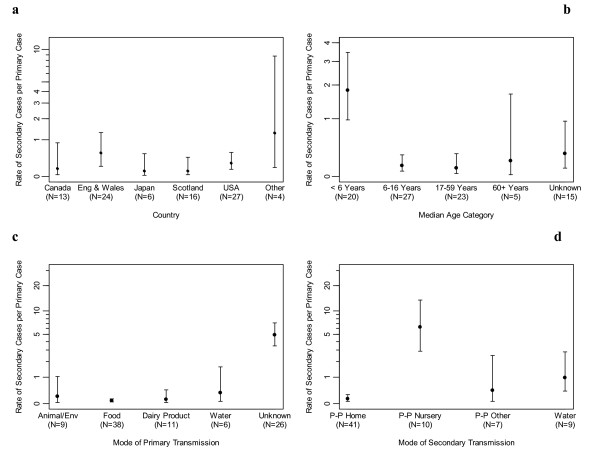
a – d. Mean rates of secondary outbreak cases per primary case. Mean (and 95% confidence intervals) rates of secondary outbreak cases per primary case, by a) country, b) median age, c) mode of primary transmission and d) mode of secondary transmission shown on log (1+x) scales. For 3a 'other' encompasses outbreaks from Scandinavia and Ireland, and for 3b the 'unknown' category encompasses outbreaks where the median age is not known.